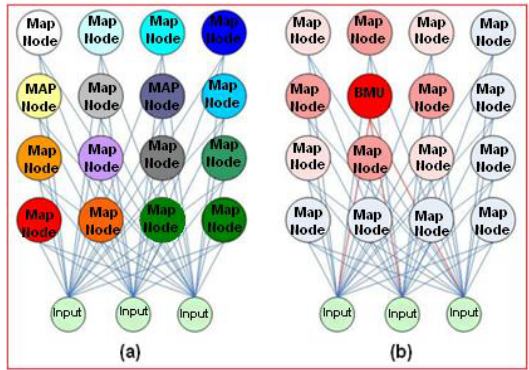
Figure 7. (a) Network initialization (b) Neighborhood adjustments.